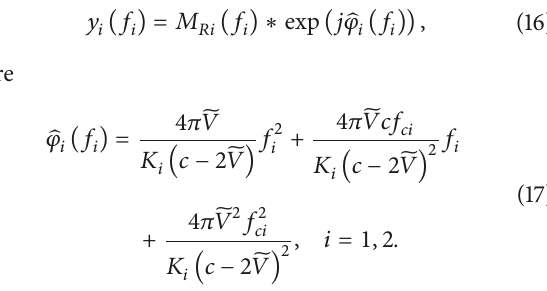
Figure 3: Extended subband data for estimation of incoherent fac-